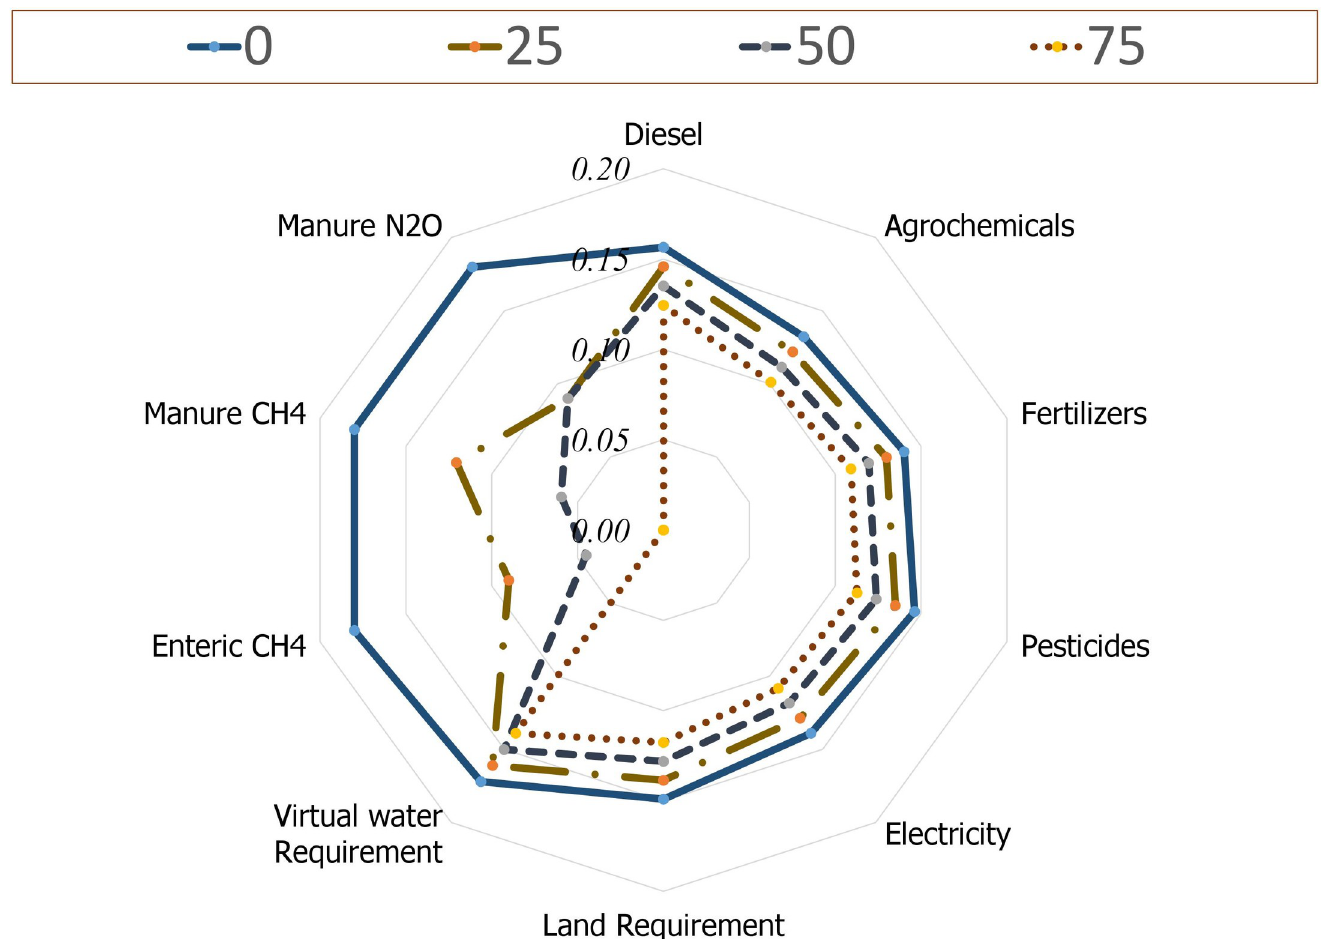
Fig 4. GWP-standpoint perceptual map of different feeds employed in the present